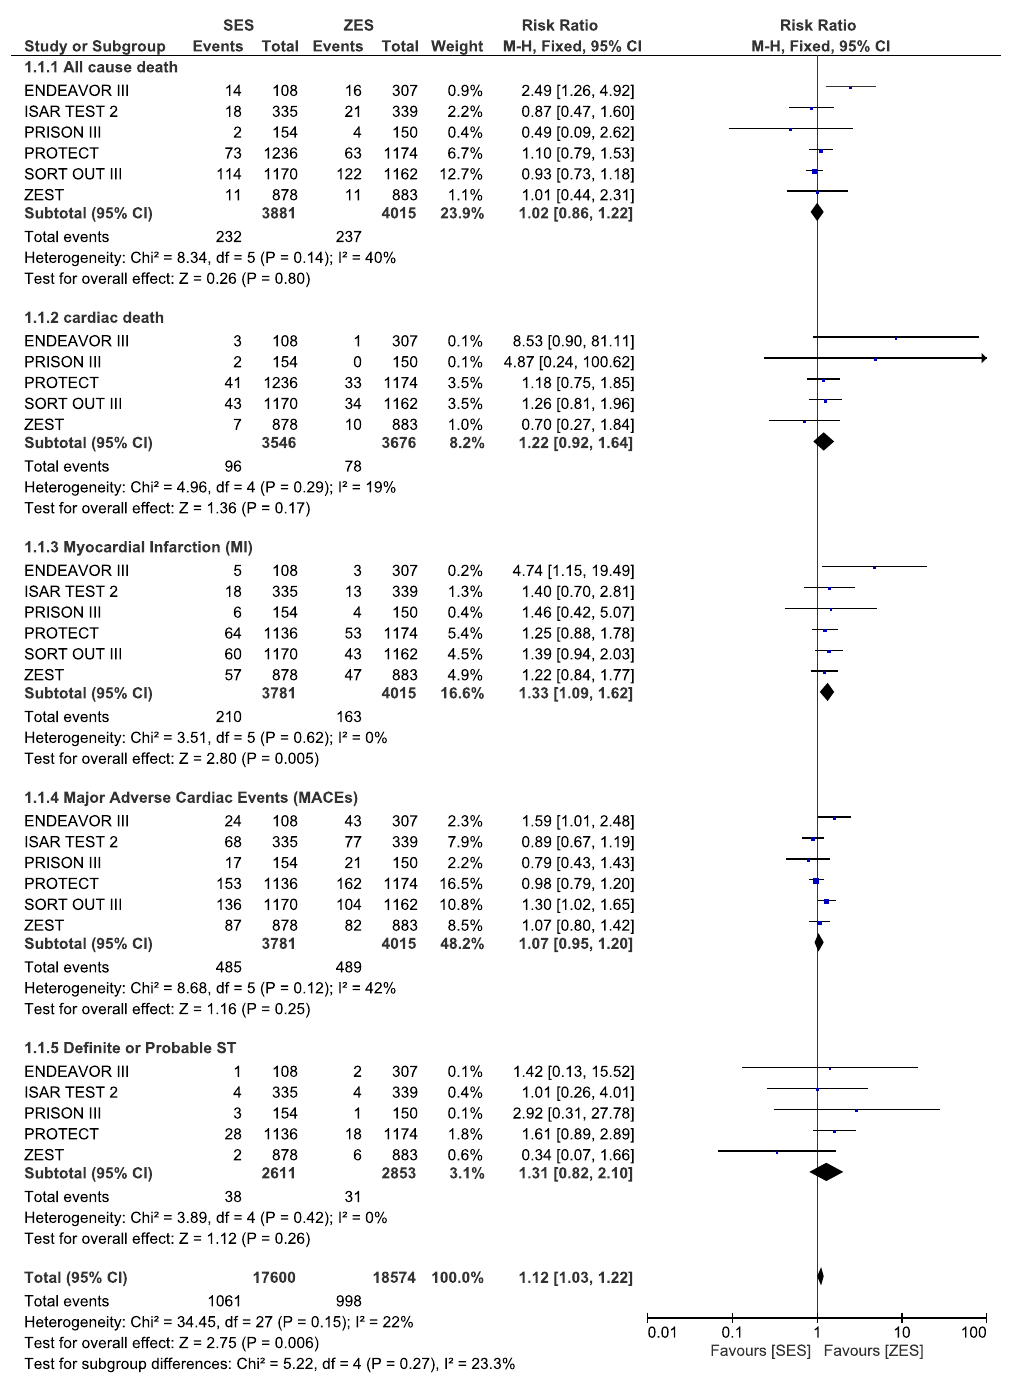
Figure 5. Long-term adverse clinical outcomes which were associated with ZES versus SES alone (part